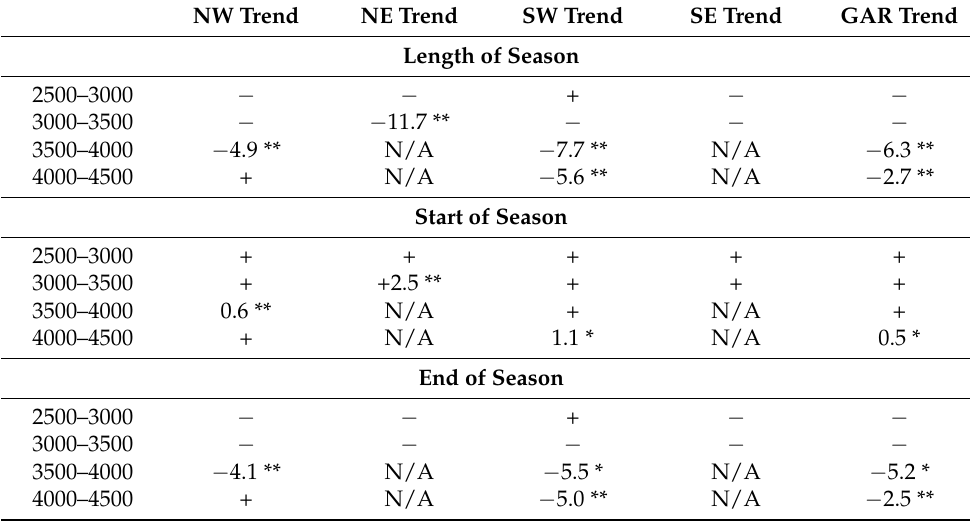
Figure 10. ( a ) Frequency of the significant trends (95% confidence level) in the length of season (LOS) normalized by the number of grid cells in each elevation band in the Greater Alpine Region by filtering out grid cells with varying glacier coverage from the Randolph glacier inventory). ( b ): Frequency of the significant trends (95% confidence level) in the length of season (LOS) normalized by the number of grid cells in each elevation band in the Greater Alpine Region when all glacier cells are removed. ( c , d ) show examples of glacier groups (Aletsch, Switzerland and Mont Blanc, Italy/France) with the trends superimposed. Table 6. Trends in the snow cover metrics for different subregions and elevation bands in days per decade. Glacier cells are omitted. * Indicates trends significant at the 90% confidence level; ** indicates trends significant at the 95% confidence level. Only the elevation bands between 2500 and 4500 m a.s.l. are